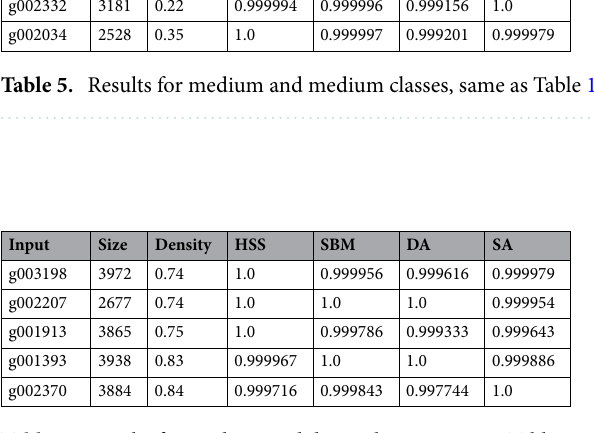
Table 6. Results for medium and dense classes, same as Table 1.